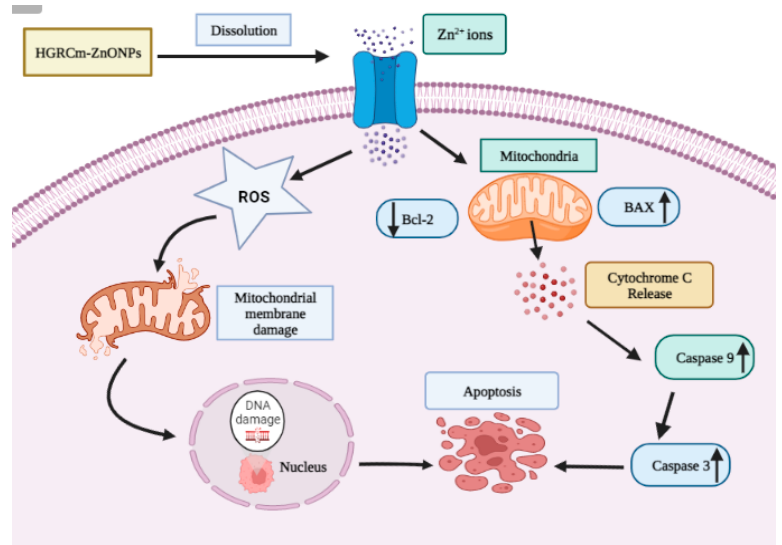
Figure 9. Cellular apoptosis via the intrinsic mitochondrial pathway. The intrinsic pathway is acti- vated by intracellular stimuli such as DNA damage or oxidative stress. Activation of mitochondrial- mediated apoptosis, which is indicated by inhibition of Bcl-2 and an increase in BAX, permits the release of Cyt c into the cytoplasm and, ultimately, the upregulation of Caspase 9/3 genes to activate the intrinsic apoptotic signaling cell death